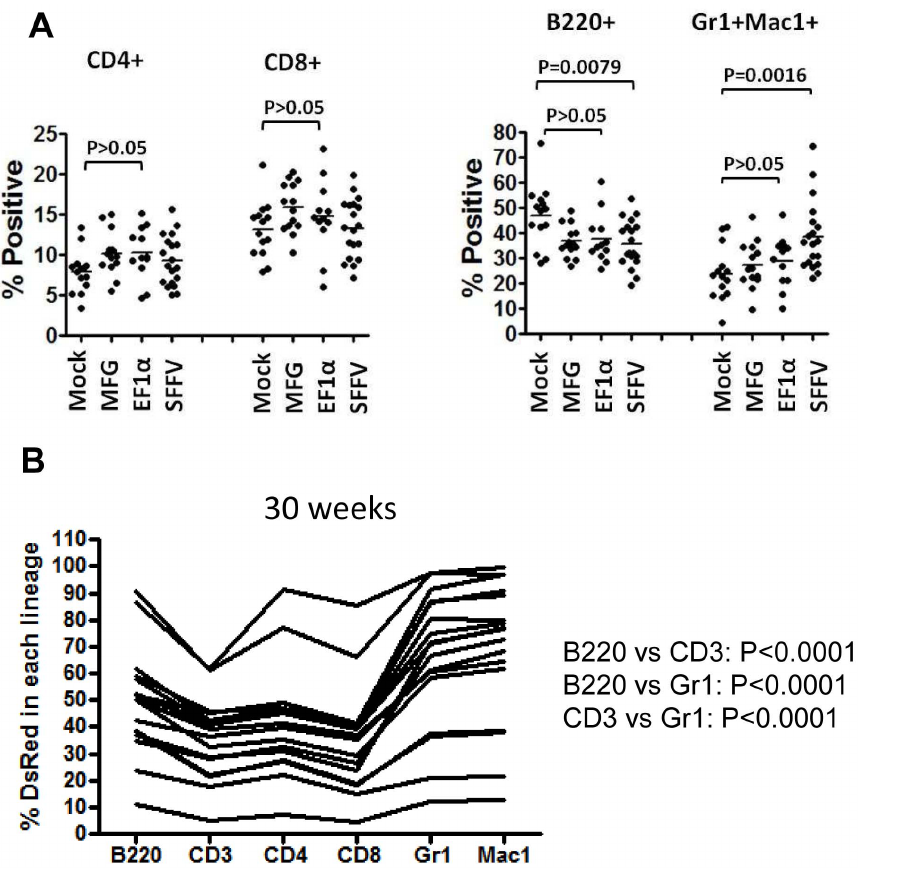
Figure 5. Skewing of myeloid differentiation in mice transplanted with SFFV-transduced cells. (A) Percentage of peripheral blood cells in specific hematopoietic lineages at 30 weeks after transplantation. Each dot represents the percent of cells from a given lineage, as determined by flow cytometry, from a single primary transplant recipient from each of the vector groups listed on the X-axis. Statistical comparisons are shown for the indicated groups giving the p value. This analysis demonstrated a significant increase in cells expressing either the Gr1 or the Mac1 marker. (B) Percentage of DsRed + peripheral blood cells in each lineage in the SFFV group of primary recipients at 30 weeks after transplant. Each line represents the profile from a single mouse and the lineages are indicated on the X-axis.